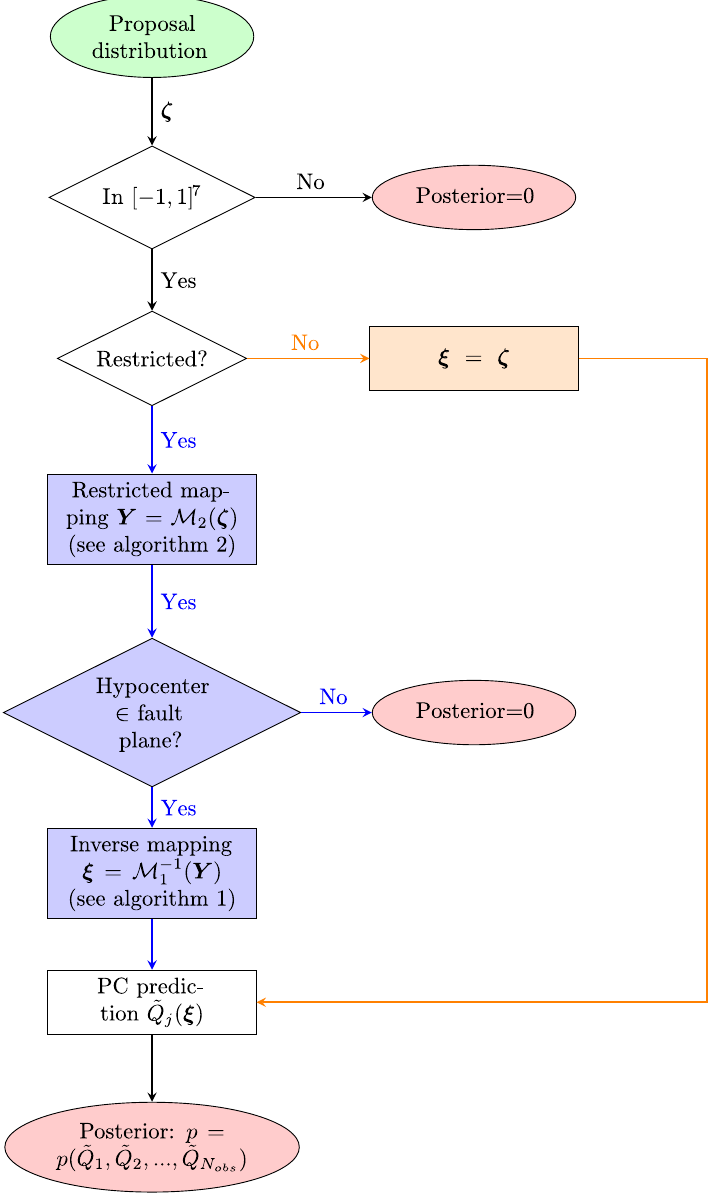
Figure 12. Flow chart demonstrating the random sampling process and the calculation of posterior probability in MCMC. The orange path corresponds to unrestricted sampling process, whereas the blue path incorporates additional restrictions on fault plane configurations. Note that Y denotes the fault plane configuration vector in the physical domain, e.g., Y